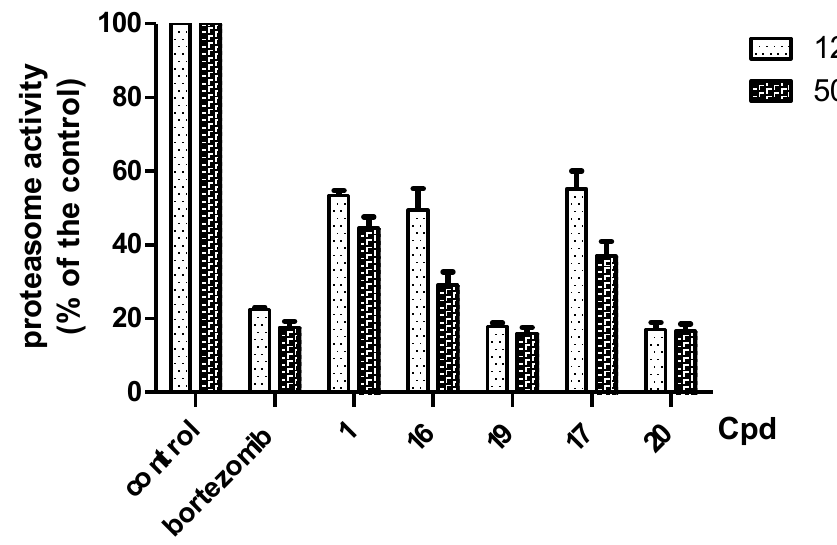
Figure 2. Effects of bortezomib and its derivatives on proteasome inhibition. Sk-hep1 cells were exposed to 100 nM bortezomib and compounds 1 , 16 , 17 , 19 , and 20 for 5 h before measurement of proteasome activity. Columns , mean ( n = 3 ); bars ,